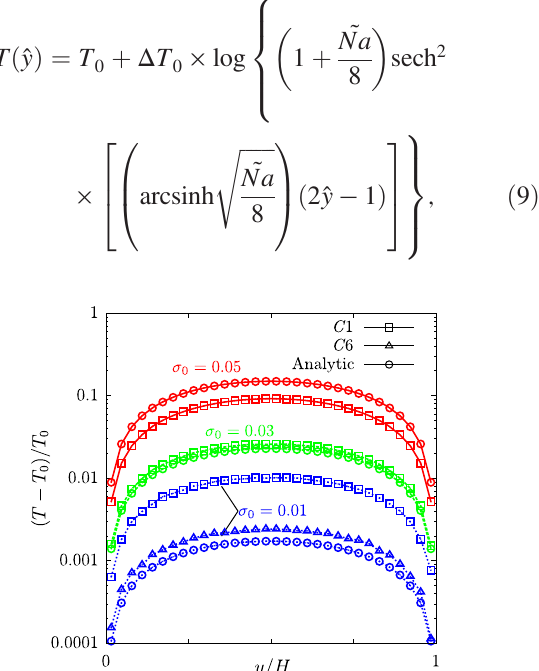
FIG. 9. The comparisons of temperature profiles between the SMD simulations and the analytic solutions for various shear